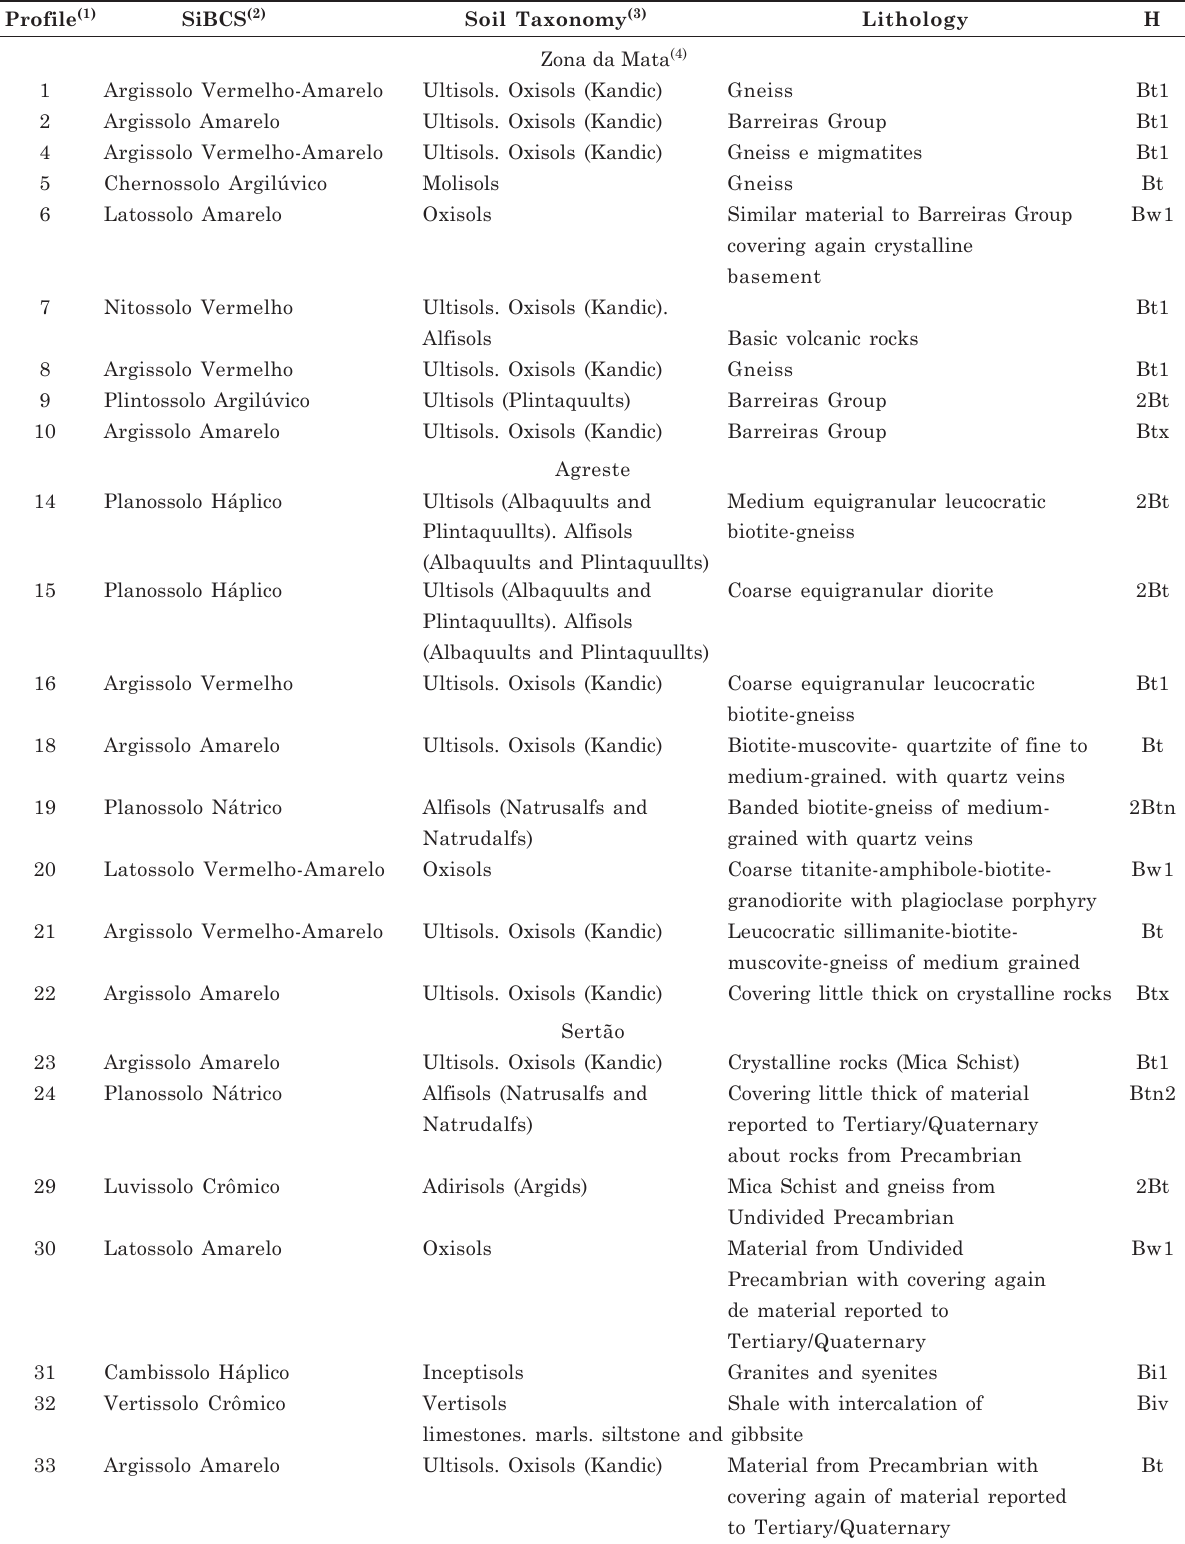
Table 1. Classification lithology and sampled horizon (H) of the studied reference soils of the State of